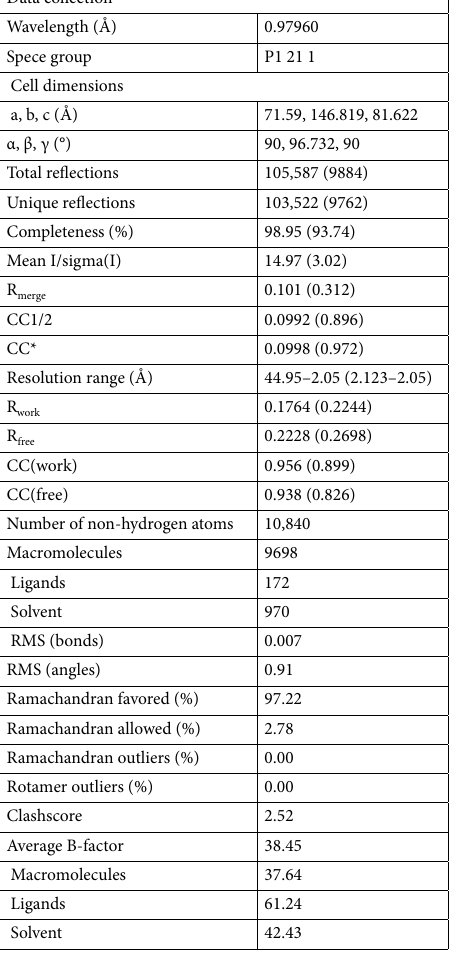
Table 1. Data collection and refinement statistics. *Statistics for the highest-resolution shell are shown in parentheses.